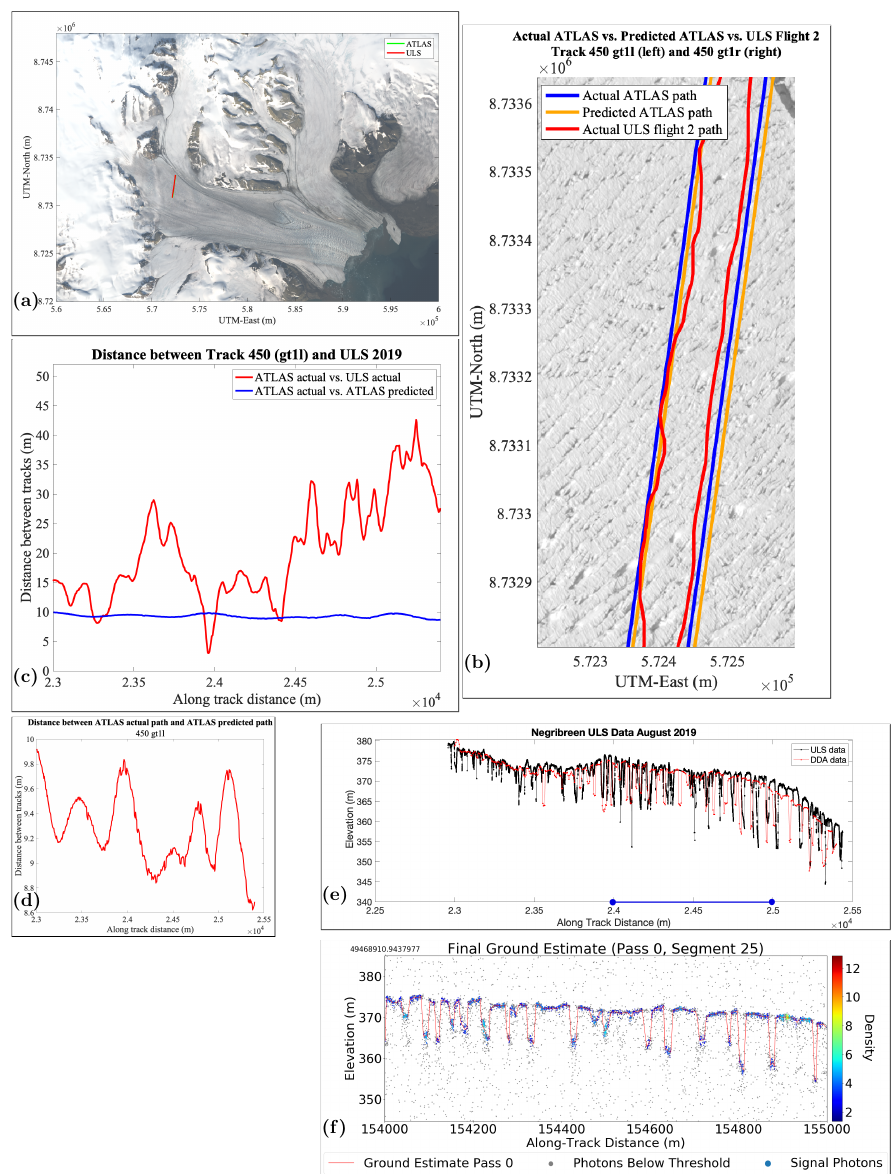
Figure 10. ICESat-2 ATLAS vs. ULS data. Track repeat accuracy and results. RGT 450, gt1l (strong). Negribreen validation campaign. Flight 2, 13 August 2019. ( a ) Location of ATLAS segments over Negribreen and closest ULS data (note the tracks are so close that the green line disappears under the red line). For segment numbering, see Figure 9 (ATLAS DDA segments). Background: